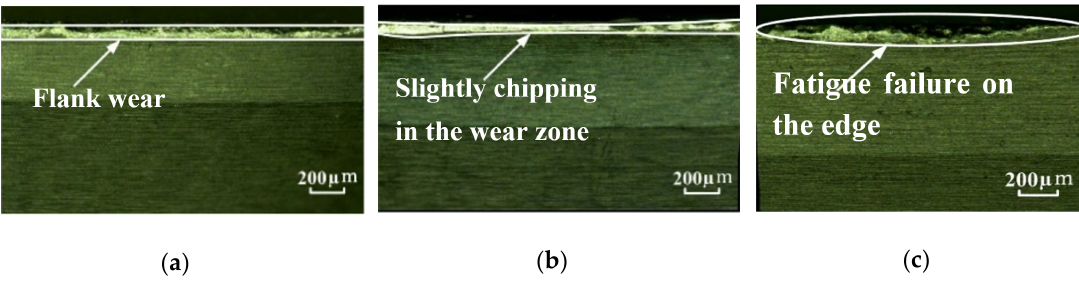
Figure 11. Tool failure morphology of 8# cutter insert at different cutting times: ( a ) t =18 min; ( b ) t = 66 min; ( c ) t = 70 min.